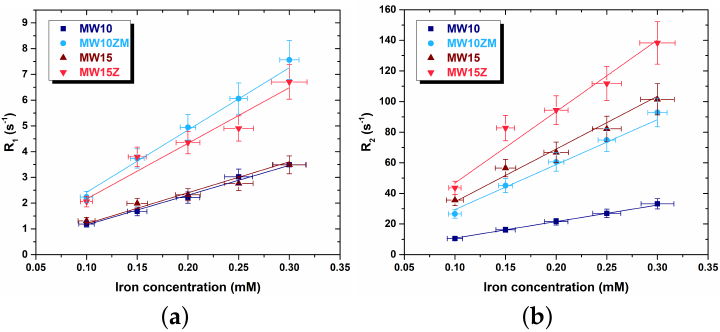
Figure 7. Longitudinal R 1 ( a ) and transverse R 2 ( b ) relaxation rates of the selected samples as a function of the iron concentration at 1.5